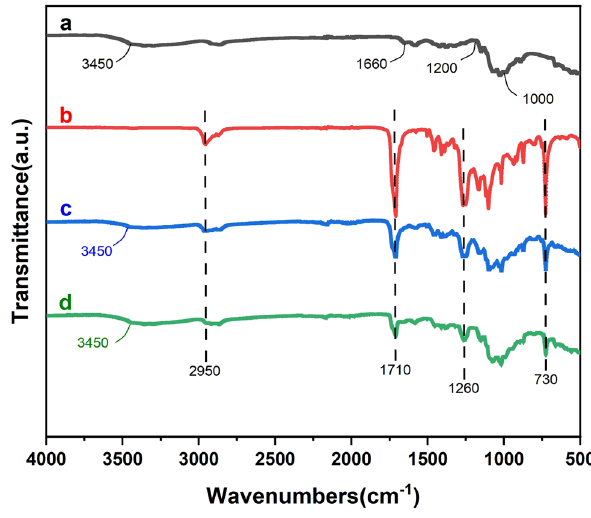
Figure 2: FTIR spectra of ( a ) CS, ( b ) PBAT, ( c ) PBAT - CS10, and ( d ) PBAT - CS20.